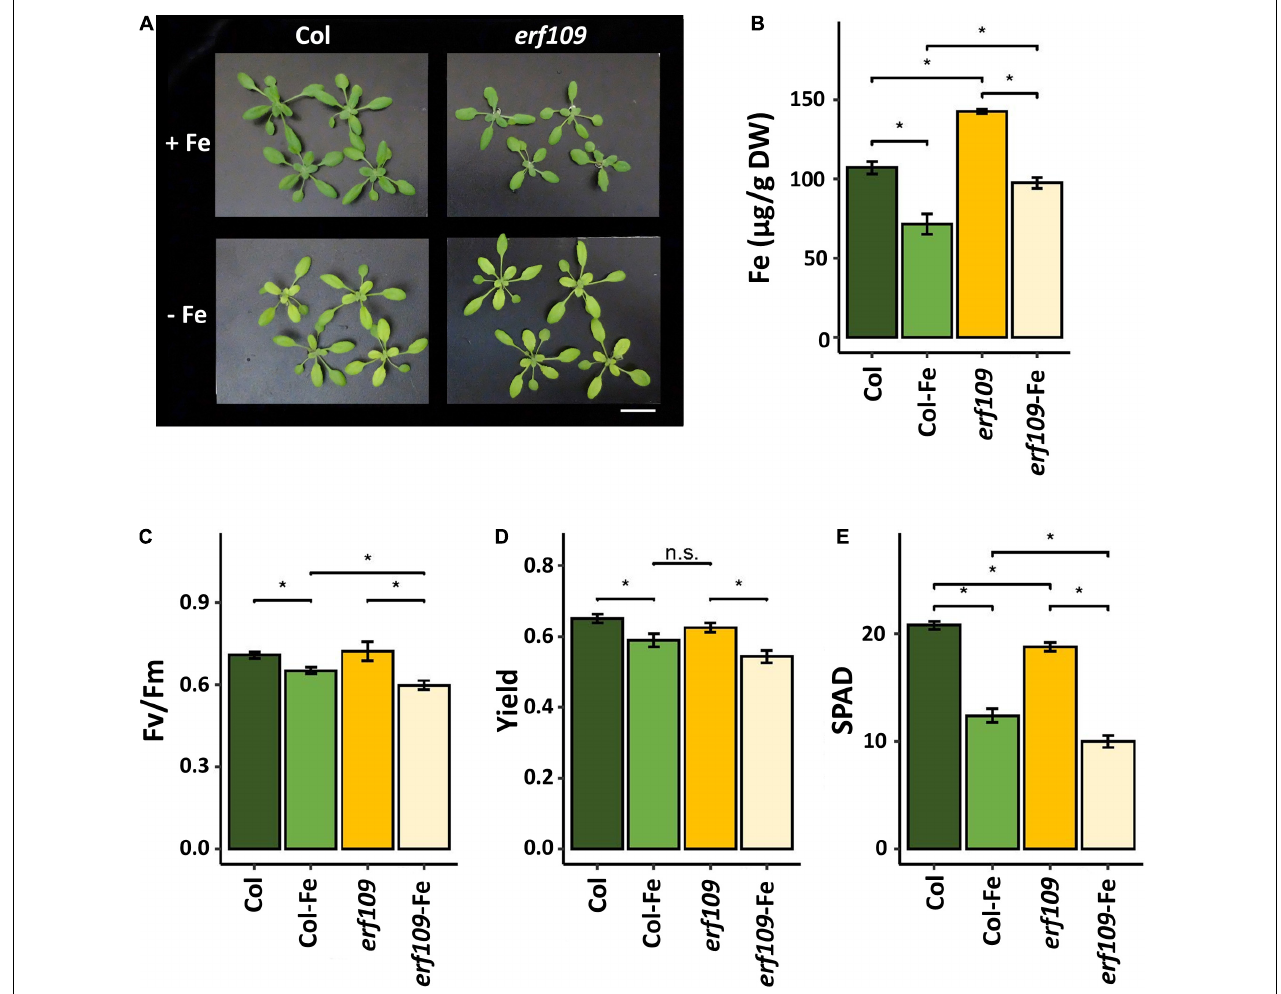
FIGURE 1 | Phenotype of erf109 mutant plants and Col-0 wild-type. (A) Growth (21-day-old plants), (B) Fe concentration, (C) Fv/Fm ratio, (D) quantum yields of PSI, and (E) SPAD value of chlorophyll content of Col-0 and erf109 under Fe sufficiency (Col, erf109 ) or Fe deficiency (Col-Fe, erf109 -Fe). Statistically significant difference was conducted by Student’s t -test at P < 0.05 between either two selected treatment or genotype, marked as asterisk. n.s., no significant; +Fe, iron sufficient condition; –Fe, iron-deficiency treatment. Bar, 5